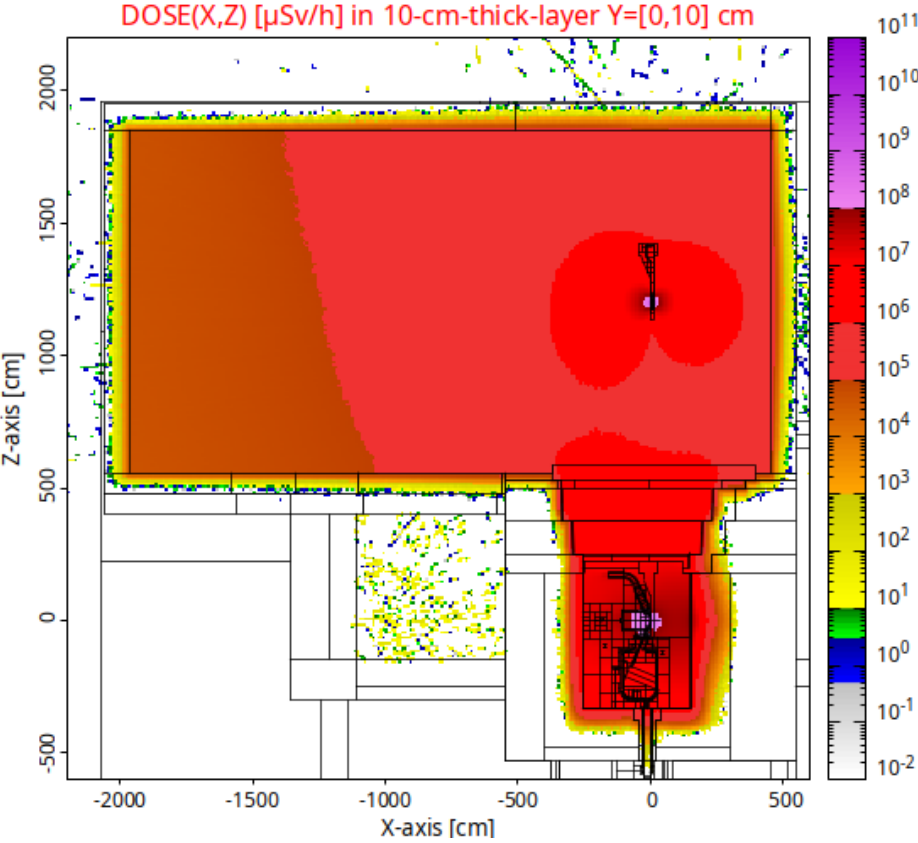
Figure 2. Shutdown dose rate (µSv/h) inside and around the Test Cell (small lower region) and Access Cell (large upper region), 1 week cooldown: the irradiated HFTM module is stationed in the Access Cell, as transported by a crane; the Test Cell is open and activated equipment as Target Assembly and others contribute to the radiation map; an efficient shielding of walls is confirmed.